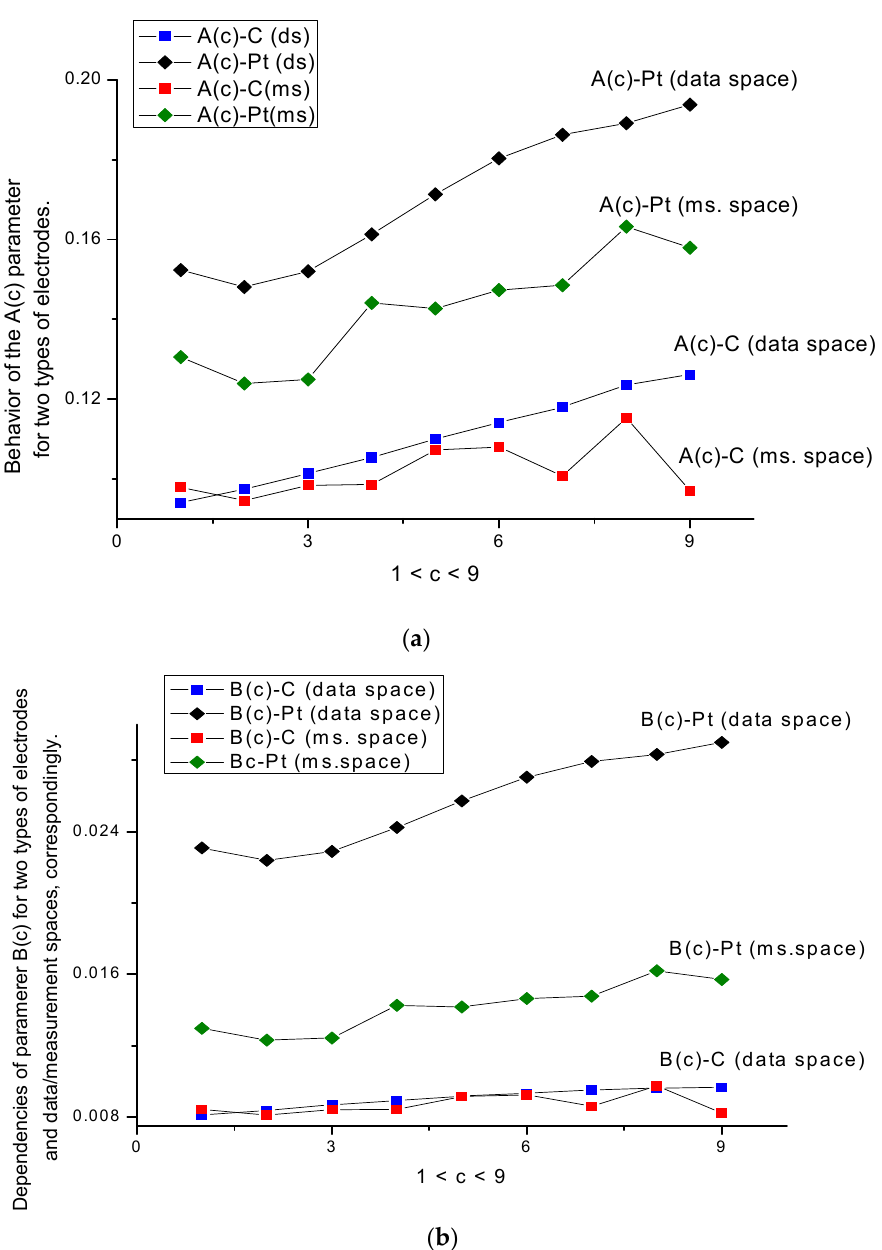
Figure 5. ( a , b ) Behavior of parameters A ( c ) and B(c) for two types of electrodes combined for the data and measurement spaces. The scale of these parameters allows this. The monotone behavior of the A ( c ) and B(c) curves for the C-electrode in data space is clearly expressed, while, for the Pt-electrode, the calculated curves in data space kept their monotone behavior only in part. In the measurement space, four curves A ( c ) and B ( c ) for both types of electrodes completely lost their monotone behavior.